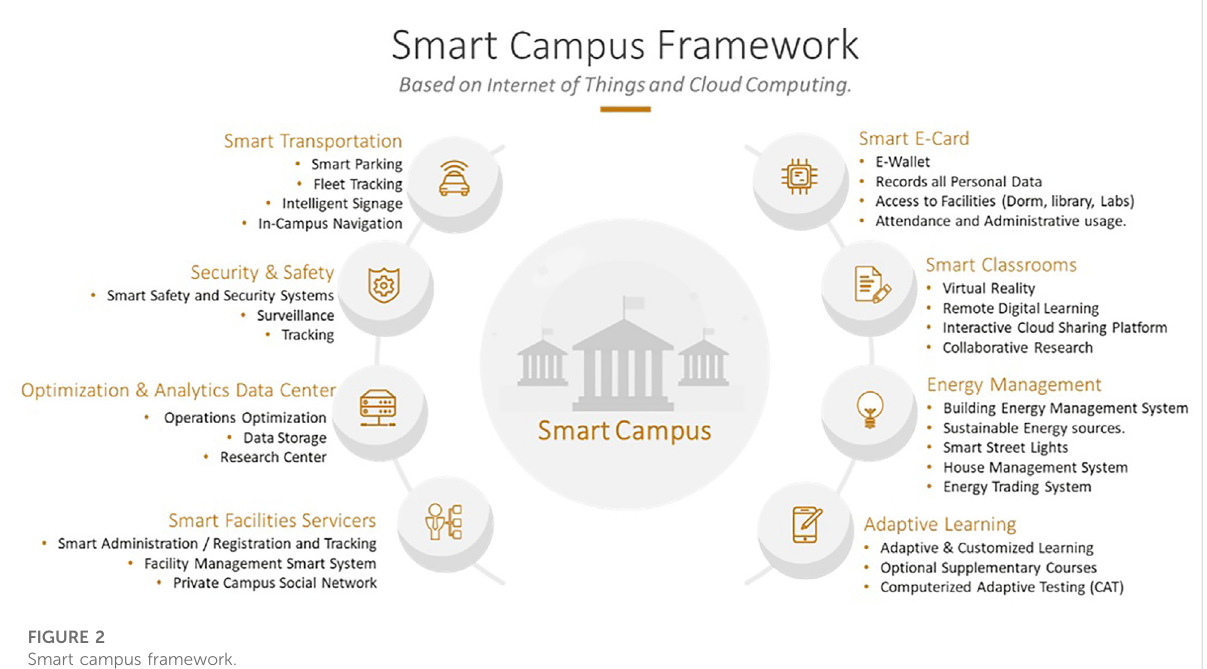
FIGURE 2 Smart campus